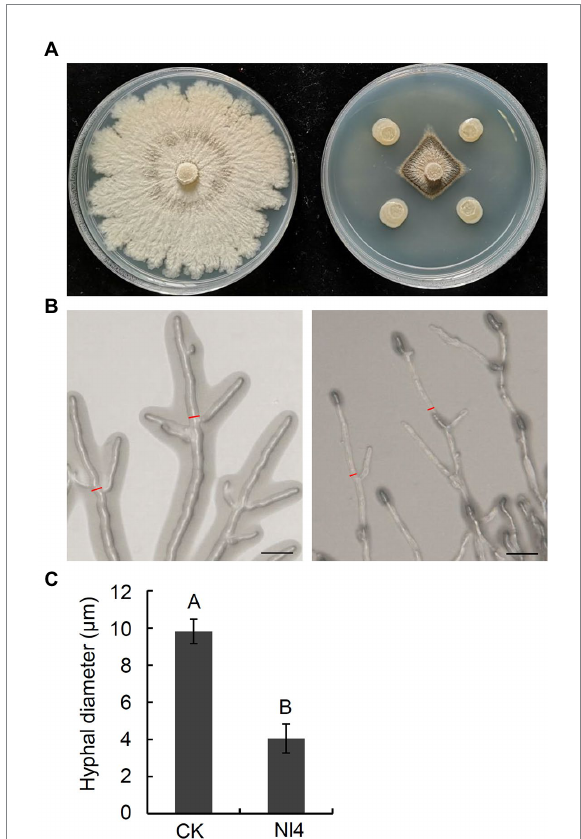
FIGURE 1 Antifungal activity of strain Nl4 against Valsa pyri . (A) Effect of strain Nl4 on mycelial growth of V. pyri . The picture was taken at 6 dpi. Left, V. pyri CK; Right, V. pyri antagonized with strain Nl4. (B) Effect of strain Nl4 on hyphal morphology of V. pyri . Hyphal morphology of V. pyri was observed at 2 days after antagonism with strain Nl4. Bar = 20 mm. (C) Hyhal diameter of V. pyri . Values are means ± SD from three replicates. The measure position of hyphae diameter was indicated in (B) with red line. Different uppercase letters indicate significant differences between CK and treatment according to Student’s t -test ( p <